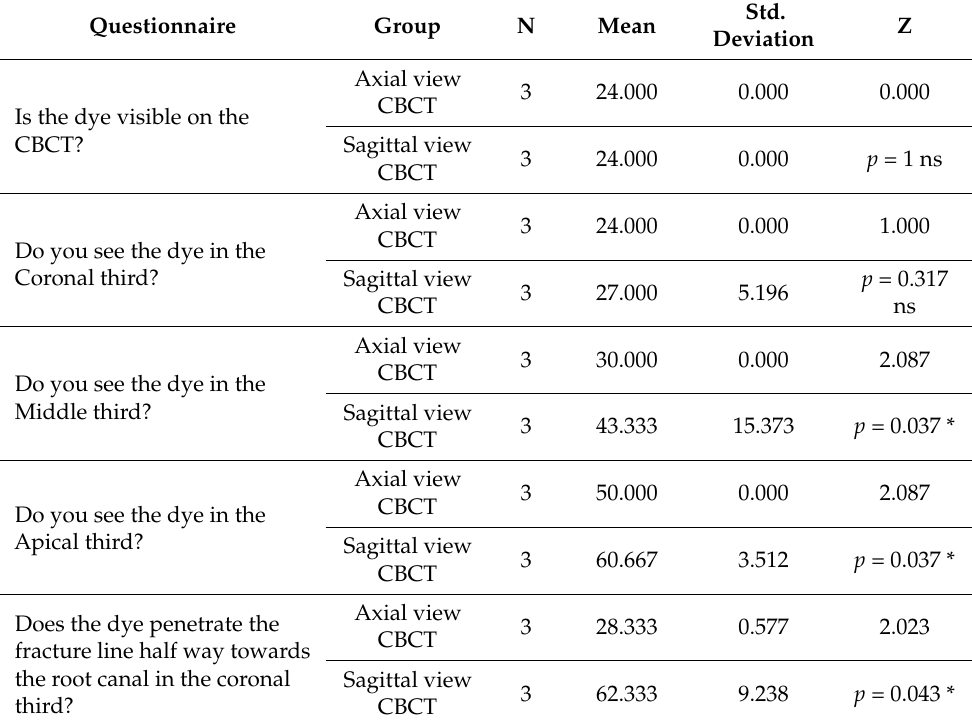
Table 5. Chi-square test based on means of Likert scale responses based on CBCT for experimental group (n =